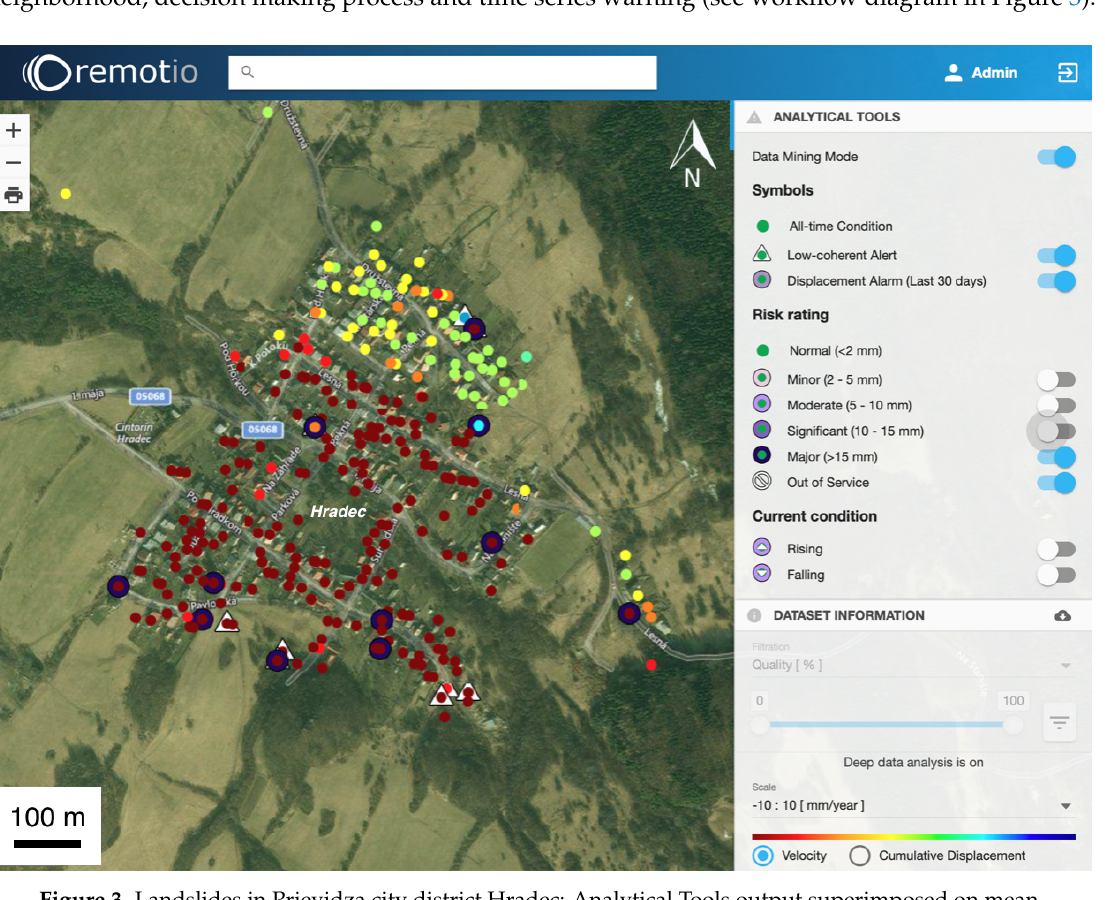
Figure 3. Landslides in Prievidza city district Hradec: Analytical Tools output superimposed on mean line-of-sight (LOS) deformation velocity map from Descending Track No. 51 shown in remotIO’s web